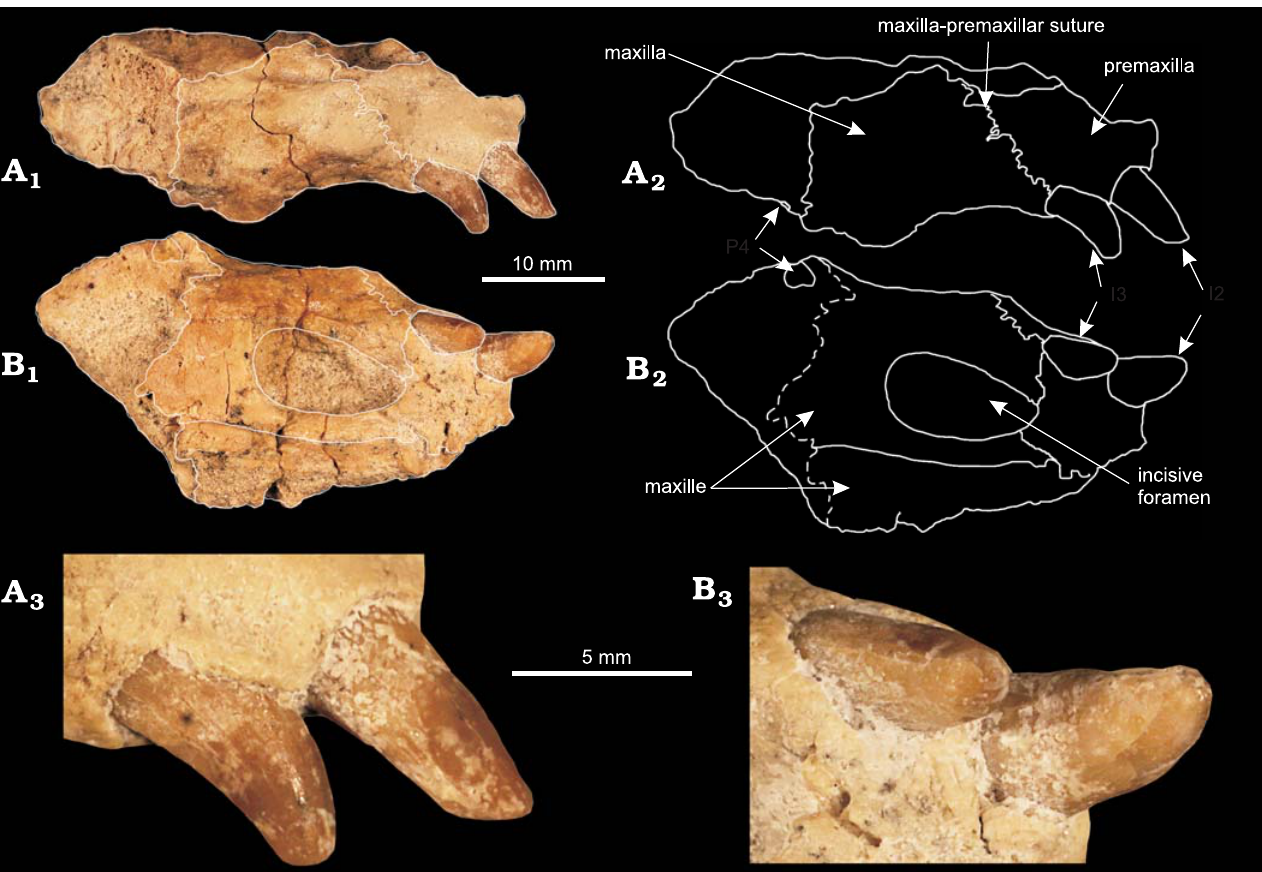
Fig. 3. Multituberculate mammal Sphenopsalis nobilis Matthew, Granger, and Simpson, 1928 (IVPP V19025) from the upper Paleocene Nomogen beds at the Erden (Urtyn) Obo locality, Inner Mongolia, China. Partial right rostrum with I2–3 in lateral ( A ) and ventral ( B ) views. A 2 , B 2 , explanatory drawings; A 3 , B 3 details of A 1 , B 1